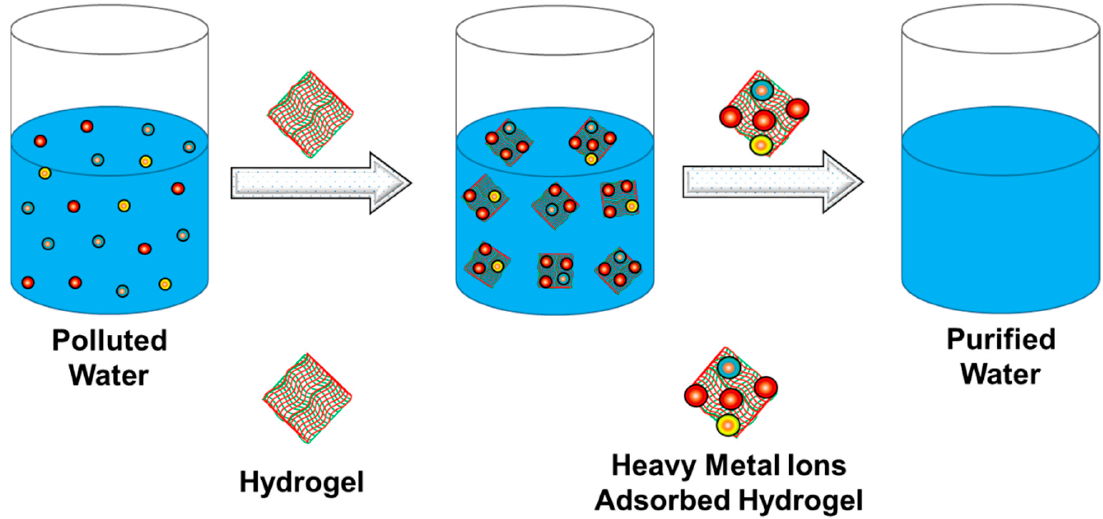
Figure 3. Schematic representation of the removal of heavy metal ions from polluted water by hydrogel adsorbents.